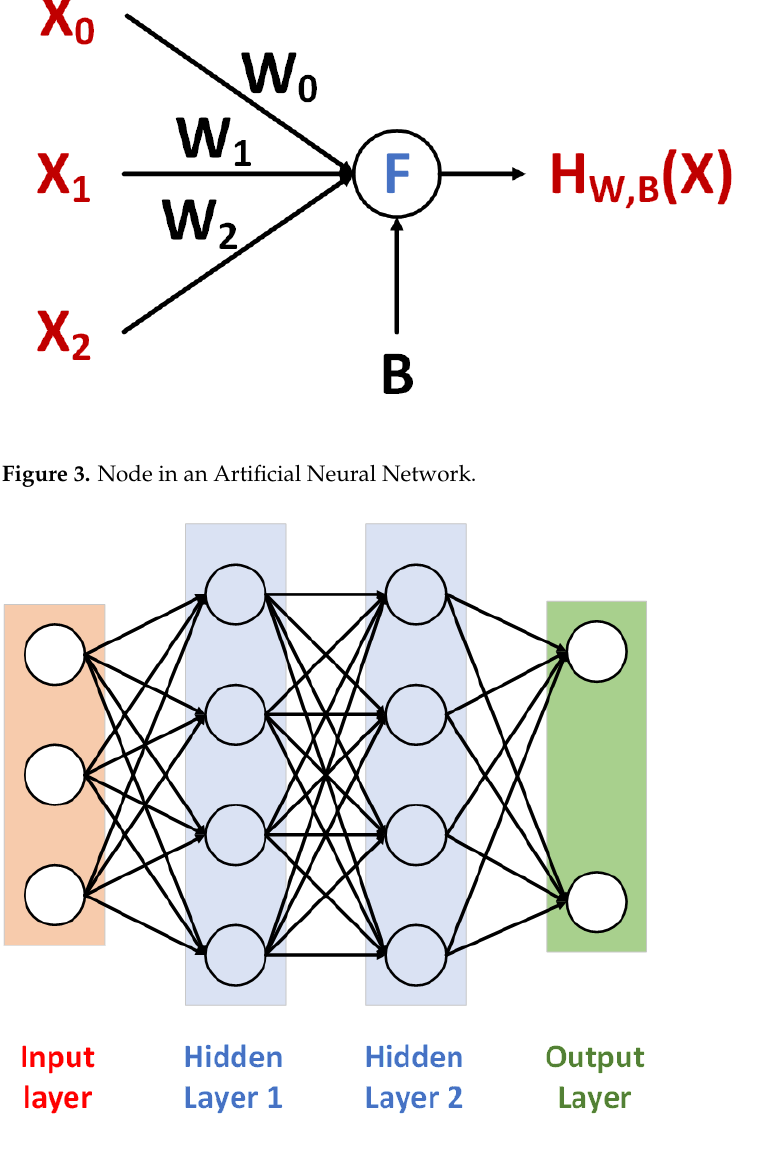
Figure 4. Artificial Neural